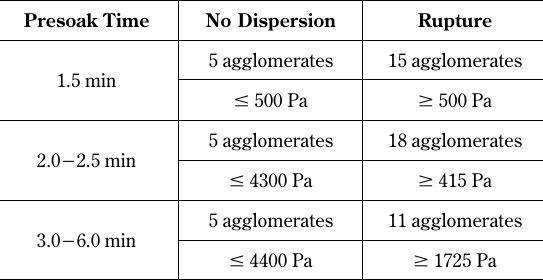
Table 2 Summary of the results of oscillatory shear experiments with hydrophobic agglomerates. The erosion mode of dis- persion was never observed.